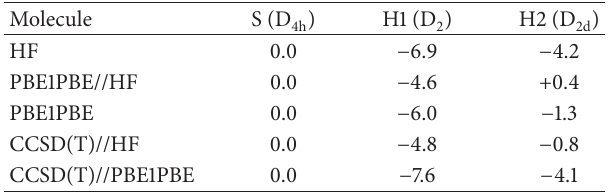
Table 3: Relative energies of N All energies are calculated with cc-pVDZ basis set. Energies are in kcal/mol. Point group symmetries of each isomer are listed with the isomer name.